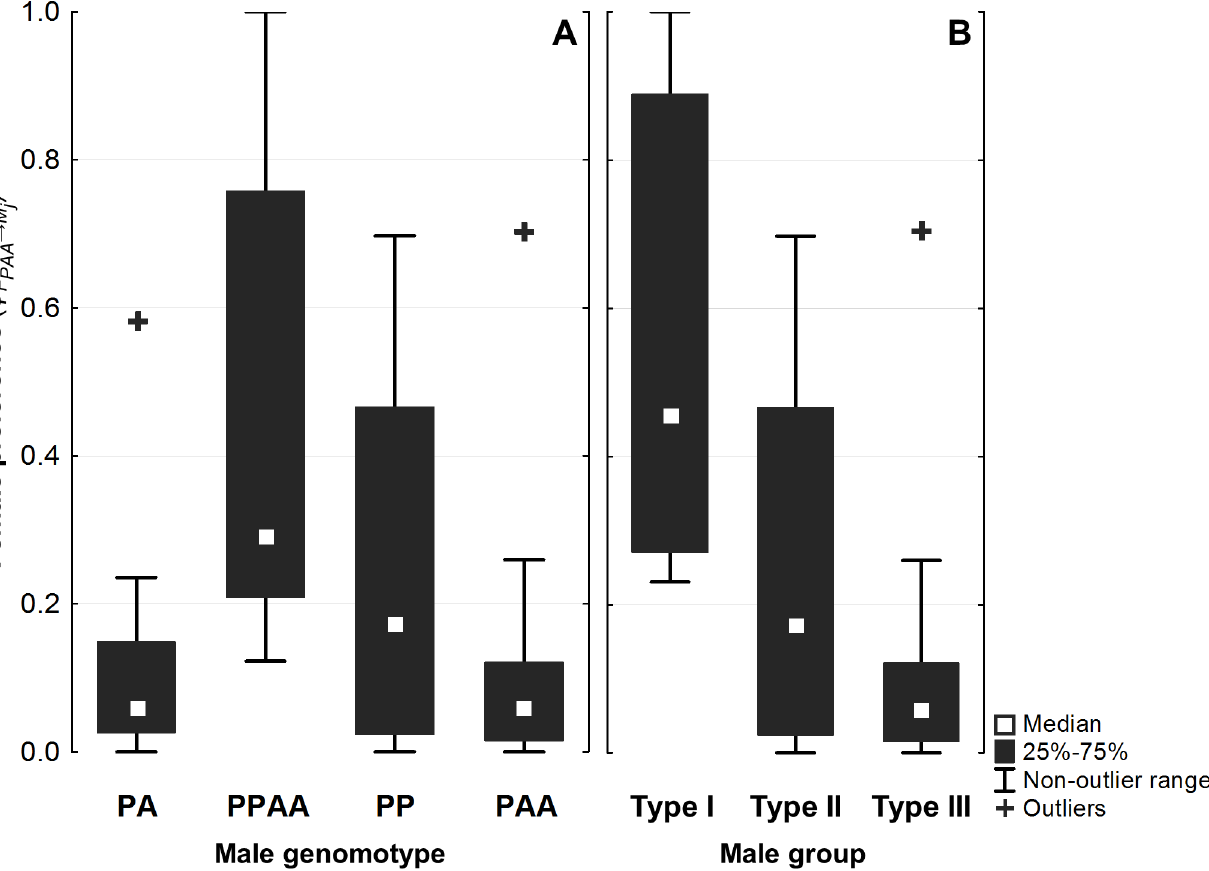
Fig 6. Mate choice results. Proportion of time spent by tested PAA females ( N = 11) near each male genomotype ( A : PA, PPAA, PP and PAA) and by male group ( B : type I, type II and type III). These results obtained from the affiliation trials were used as measures of female preference (means: φ FPAA ! MPA = 0.13, φ φ φ φ φ φ FPAA ! MPPAA = 0.45, FPAA ! MPP = 0.26, FPAA ! MPAA = 0.13; FPAA ! MI = 0.58, FPAA ! MII = 0.26, FPAA ! MIII = 0.13). theoretical model. Simulated S . alburnoides genomotype frequencies ( f